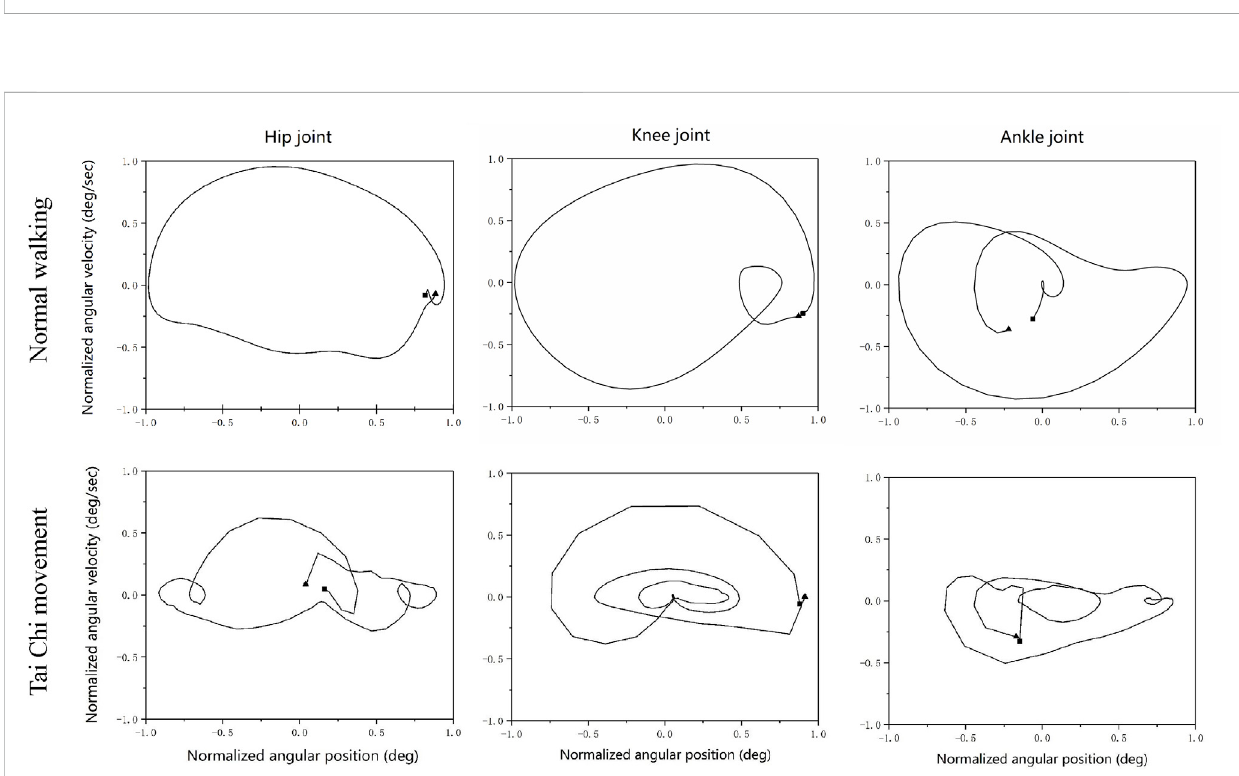
Ensemble-averaged phase plots of the hip, knee, and ankle of the lower limb in the sagittal plane for normal walking and Tai Chi movements. The longitudinal axis is normalized angular velocity and the horizontal axis is a normalized